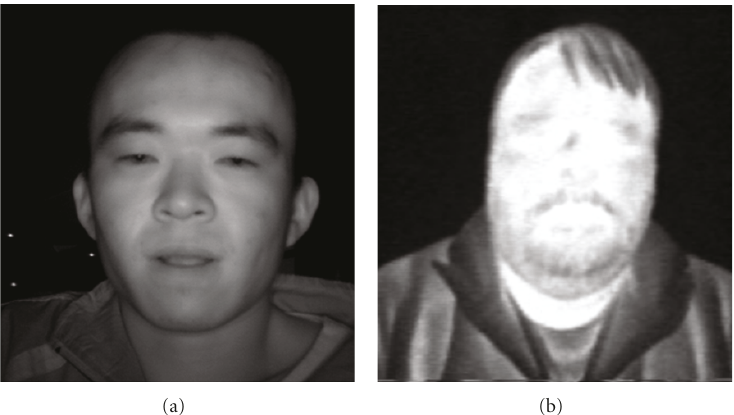
Figure 5: A near infrared image (a) from CBSR dataset [16, 17] and a thermal image (b) from Terravic Research Infrared Database [17, 18].